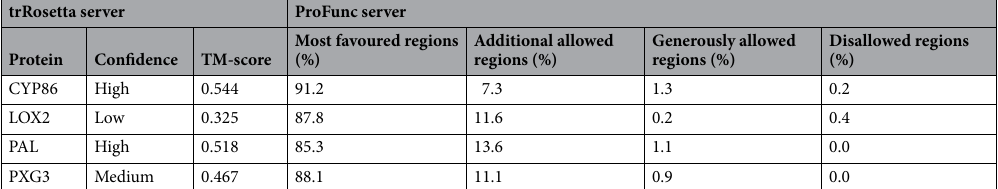
Table 5. Features of the predicted protein models on two servers, trRosetta and ProFunc. trRosetta server includes confidence and TM-score, and ProFunc server includes most favoured regions (%), additional allowed regions (%), generously allowed regions (%) and disallowed regions (%). TM-score is between 0 and 1 and a TM-score higher than 0.5 usually indicates a model with correctly predicted topology 41